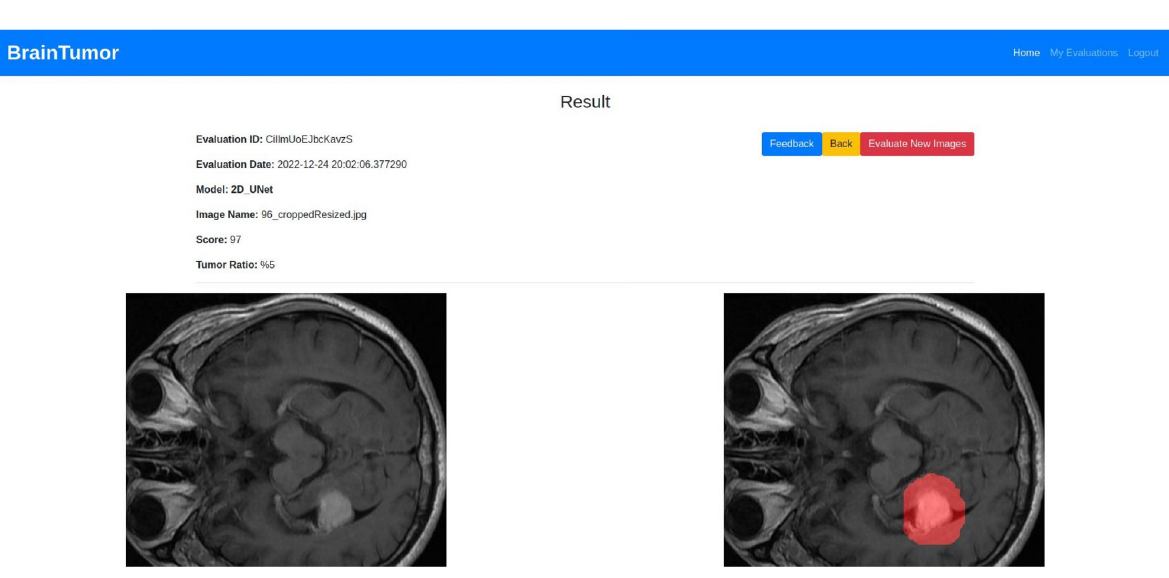
Fig 18. Show results page.